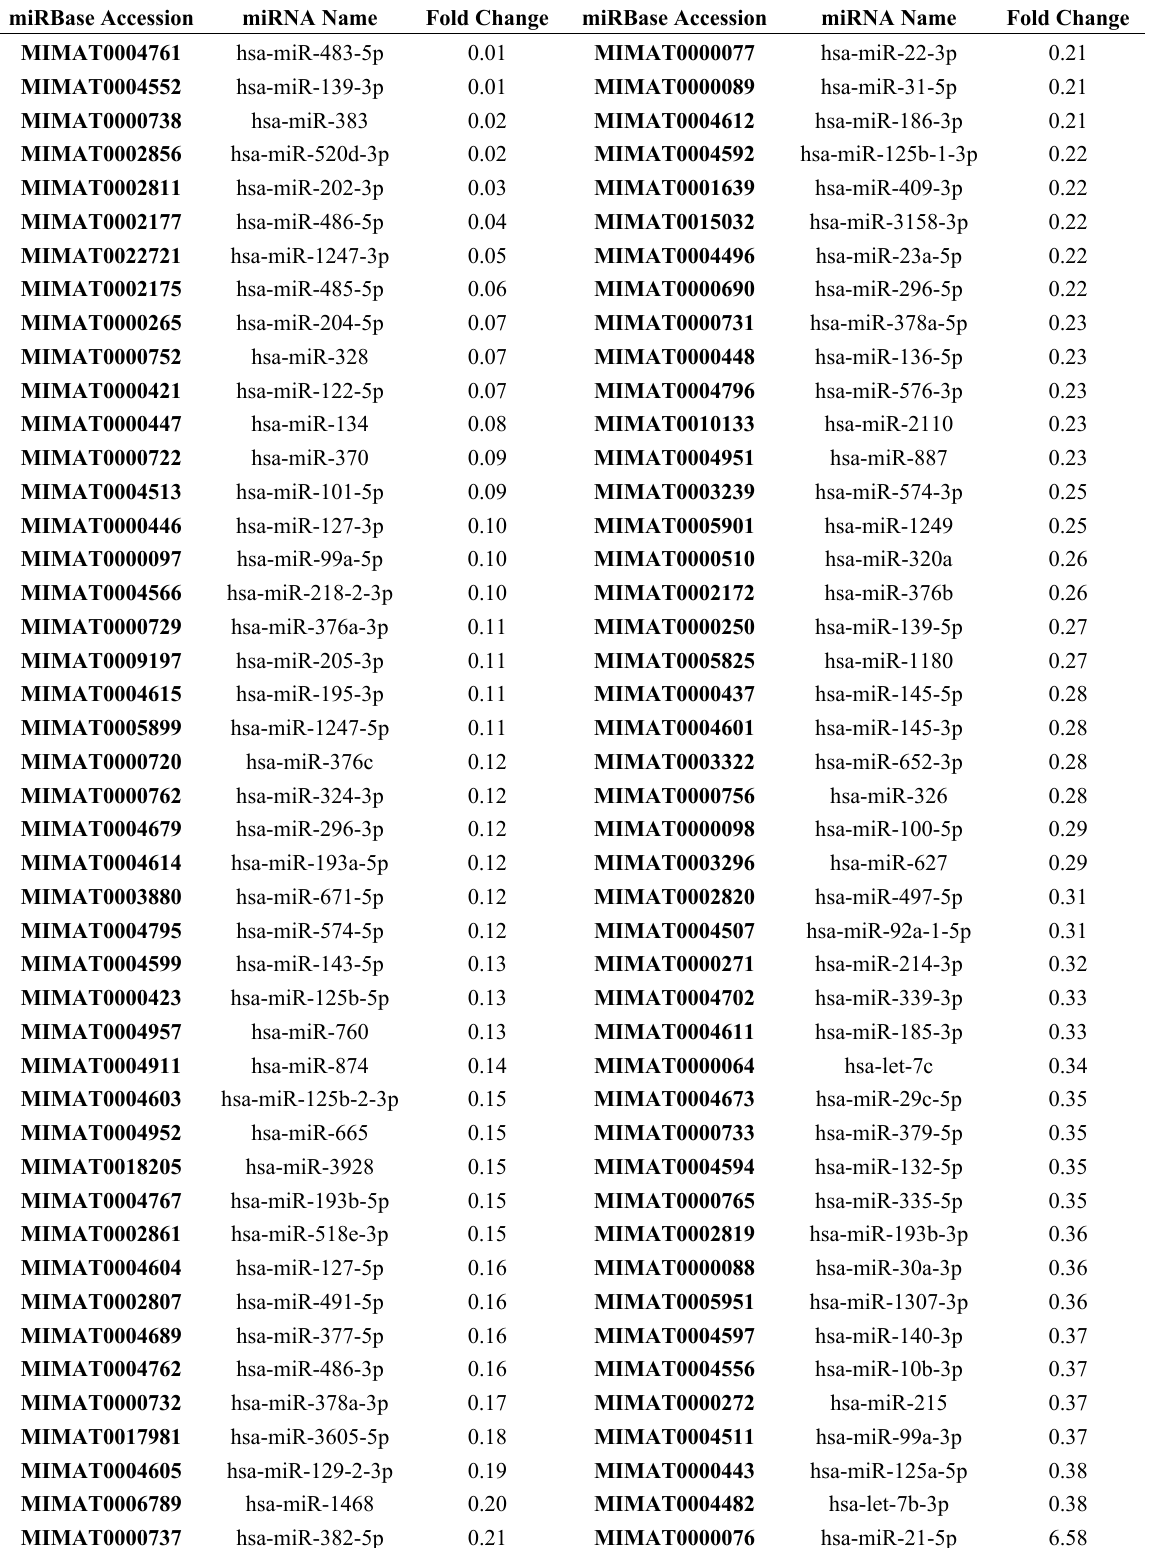
Table S1. Significantly differentially expressed miRNAs found in miRNA dataset in Farazi et al . [26]. There are 89 down-regulated miRNAs and 1 up-regulated miRNA in